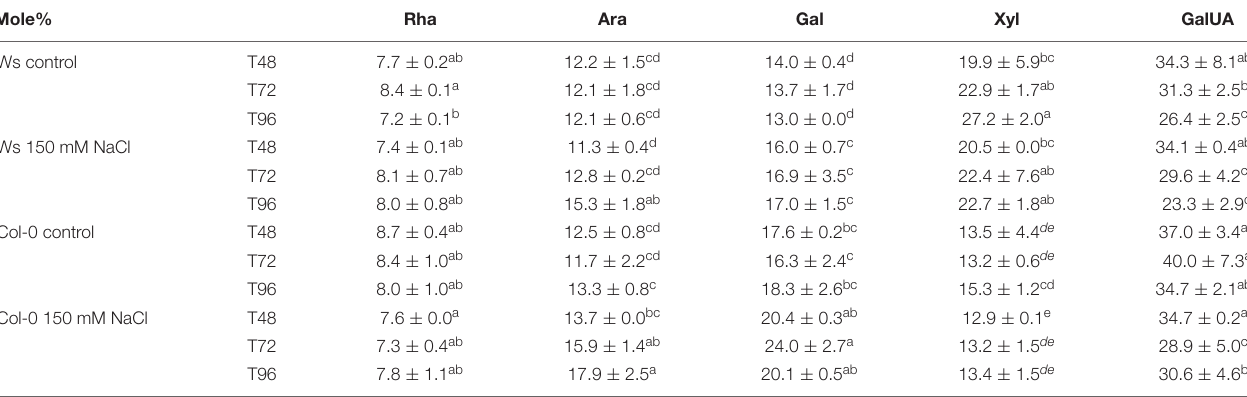
TABLE 2 | Monosaccharide distribution of non-cellulosic cell wall polysaccharides in Ws and Col-0 at T48, T72, and T96 under control and 150 mM of NaCl conditions. l-Arabinose (Ara), d-galactose (Gal), d-xylose (Xyl), and l-galacturonic acid (GalUA) content.